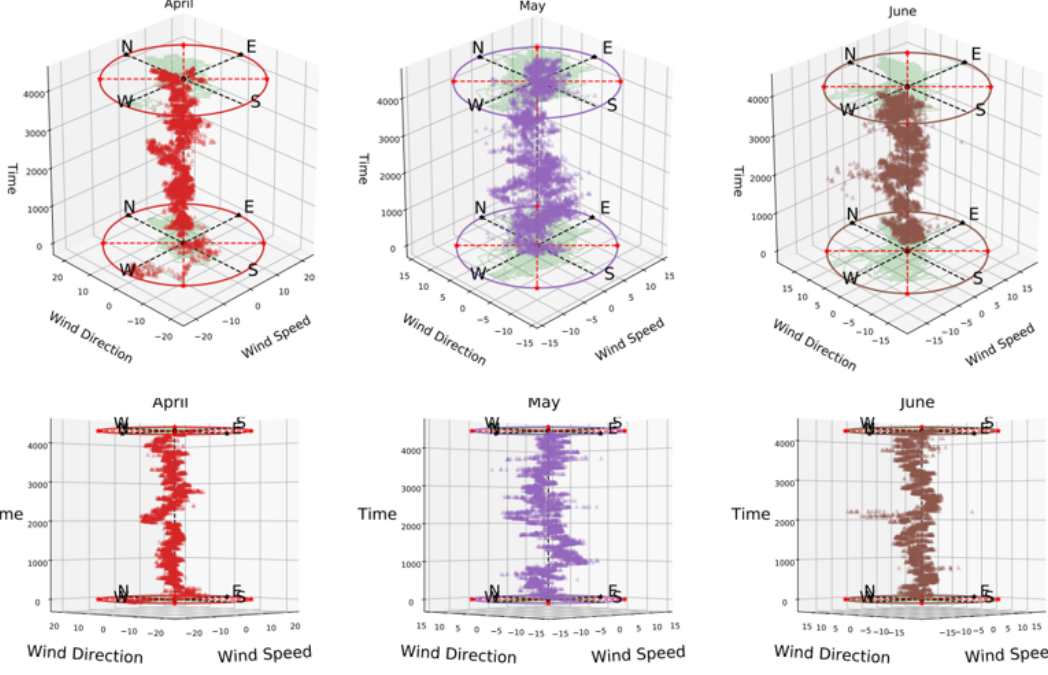
Figure 10. The wind speed with direction and time as a vertical axis to observe the blowing